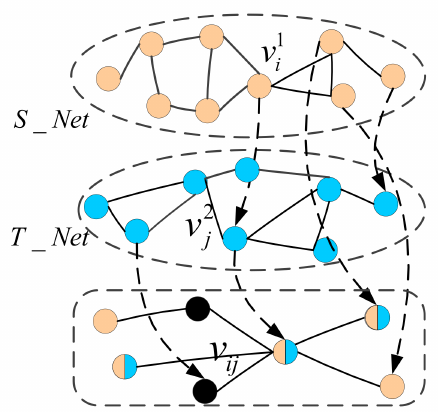
Figure 4. The schematic diagram of node similarity calculation between